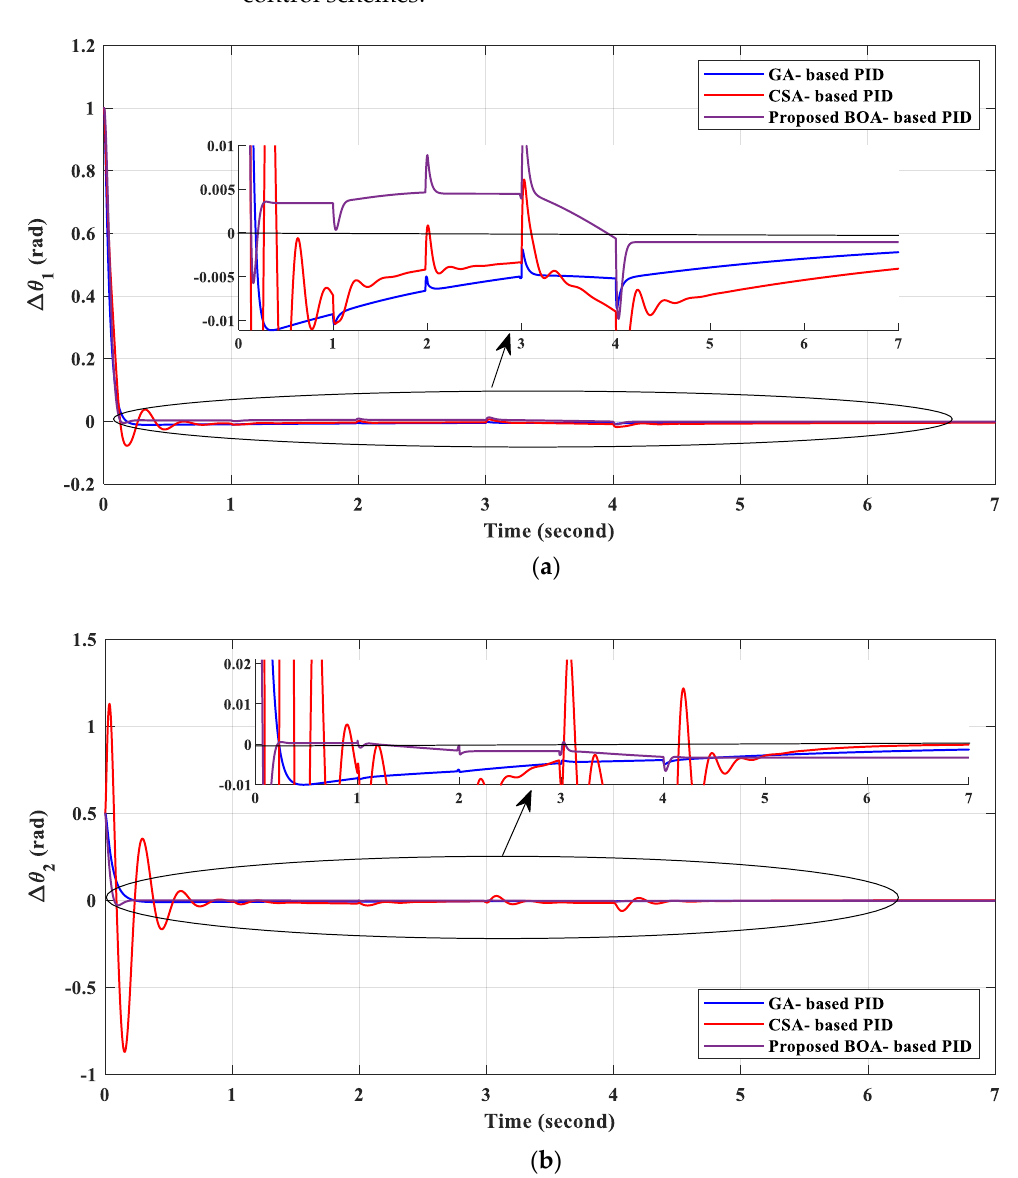
Figure 15. The link 2 output wave of as a result of random step-position trajectories; ( a ) link 2 position ( b ) link 2 position deviation.